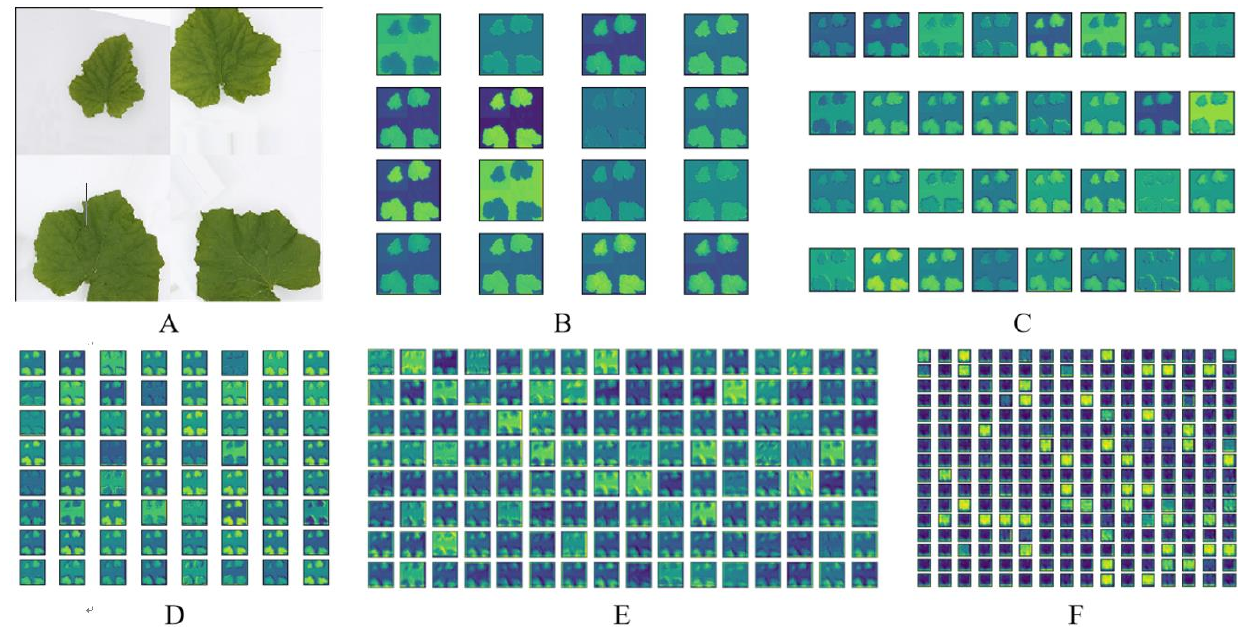
Figure 10. Feature maps of deep convolutional neural network (DCNN) model. Note: ( A ) input data; ( B – F ) feature maps of the 1st–5th convolutional layers.